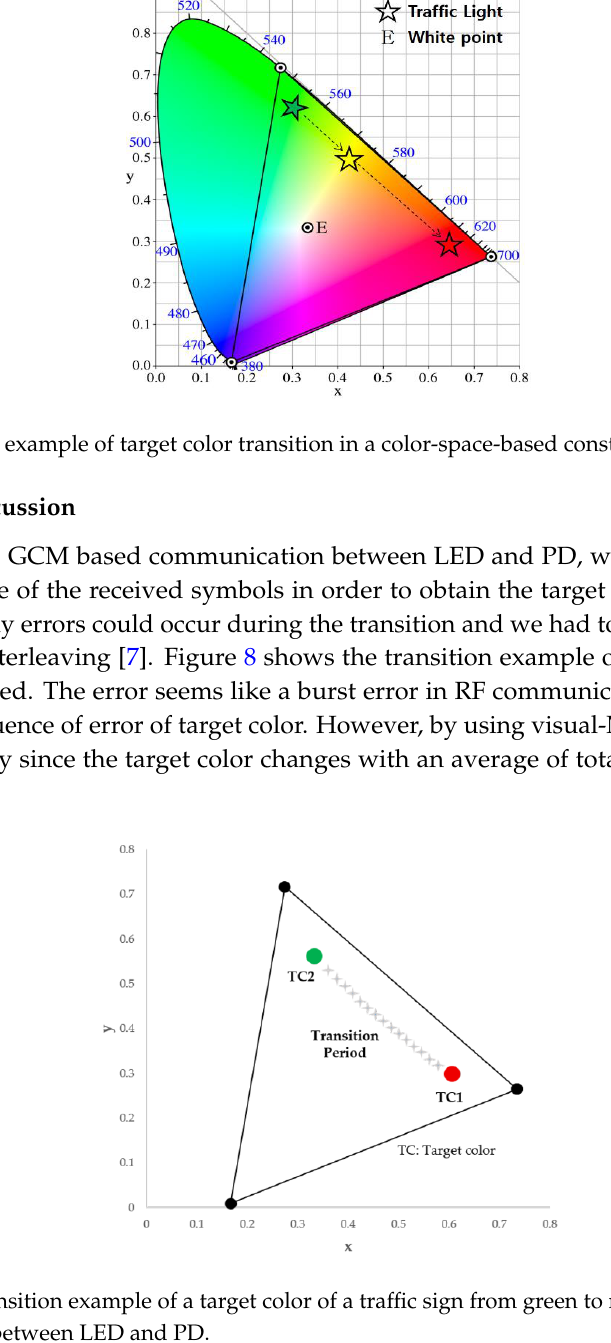
Figure 9. SER performance comparison between visual-MIMO and LED-PD communication under color variation.